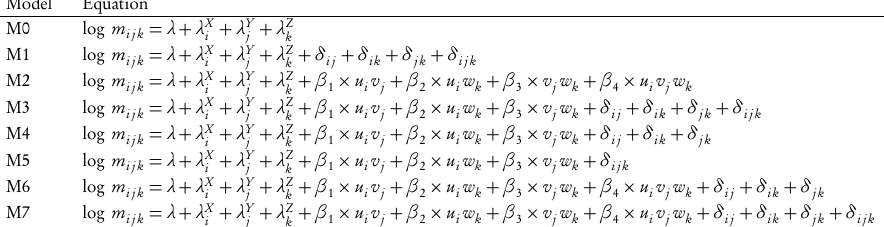
The independent, agreement, uniform association, and uniform association plus agreement models for three-rater